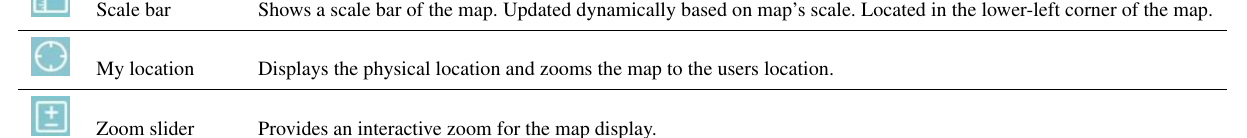
Attribute table